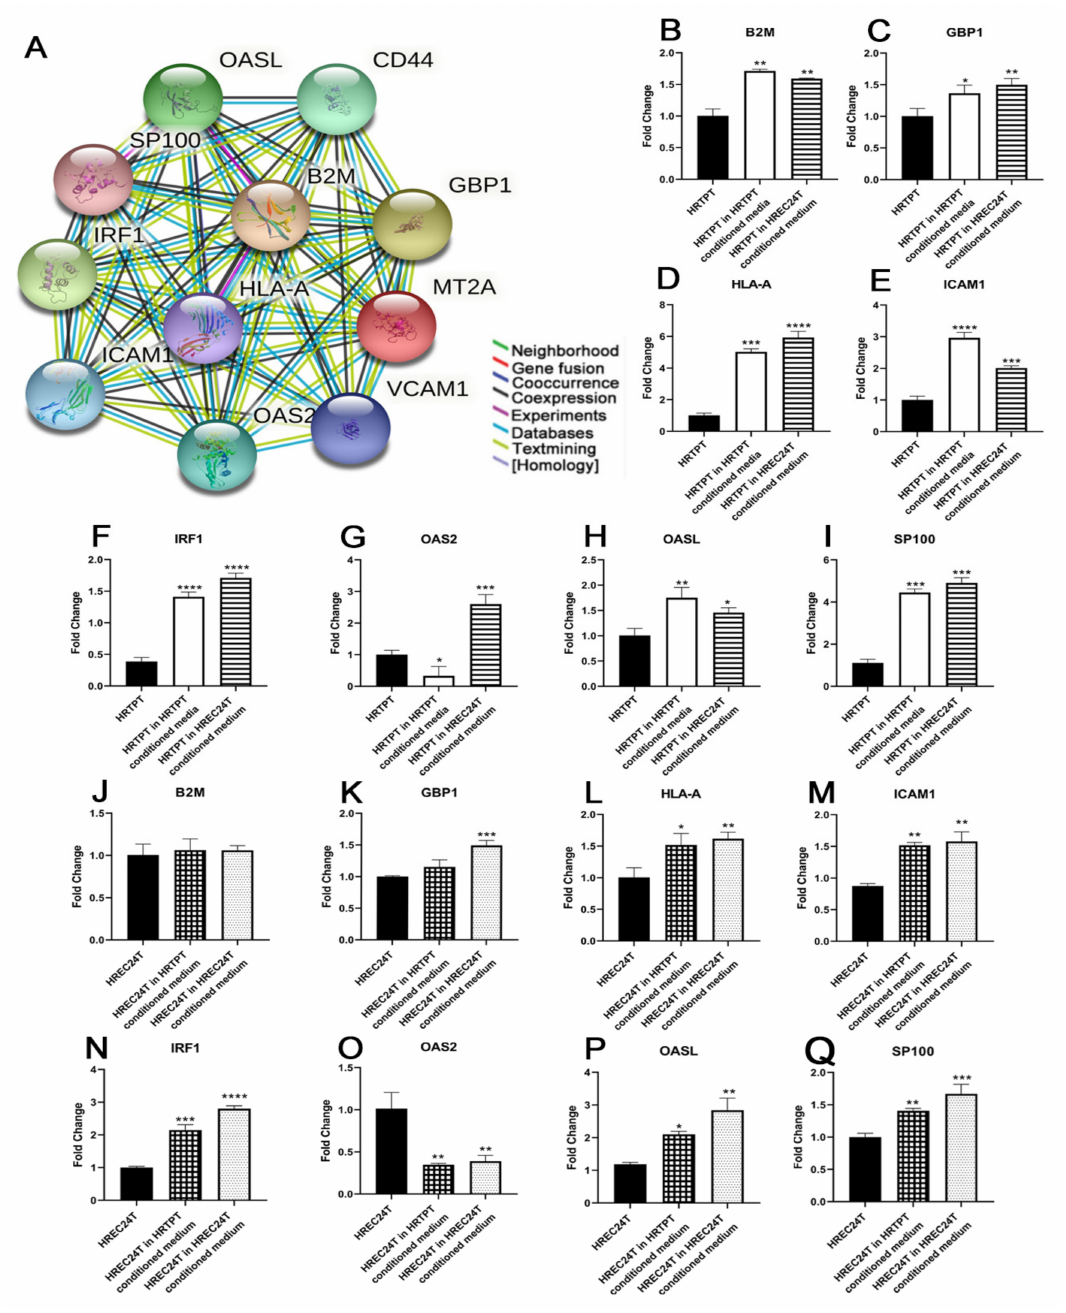
Figure 5. Expression of MT2A associated genes in HRTPT and HREC24T cells exposed to conditioned media. ( A ) MT2A showed numerous protein–protein associations, and the top 10 genes with highest string-db score were OAS2, OASL, HLA-A, SP100, B2M, CD44, GBP1, VCAM1, ICAM1, and IRF1. RT-qPCR analysis of ( B ) B2M; ( C ) GBP1; ( D ) HLA-A; ( E ) ICAM1; ( F ) IRF1; ( G ) OAS2; ( H )